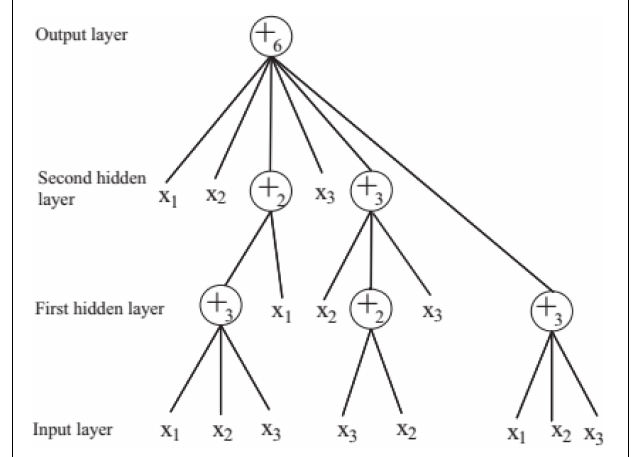
FIGURE 1 | An example of flexible neural tree.